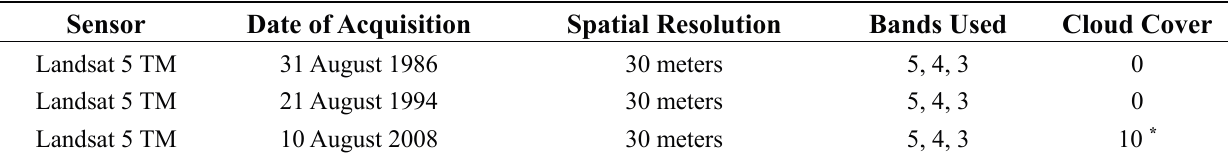
Table 2. Description of imagery used for land cover